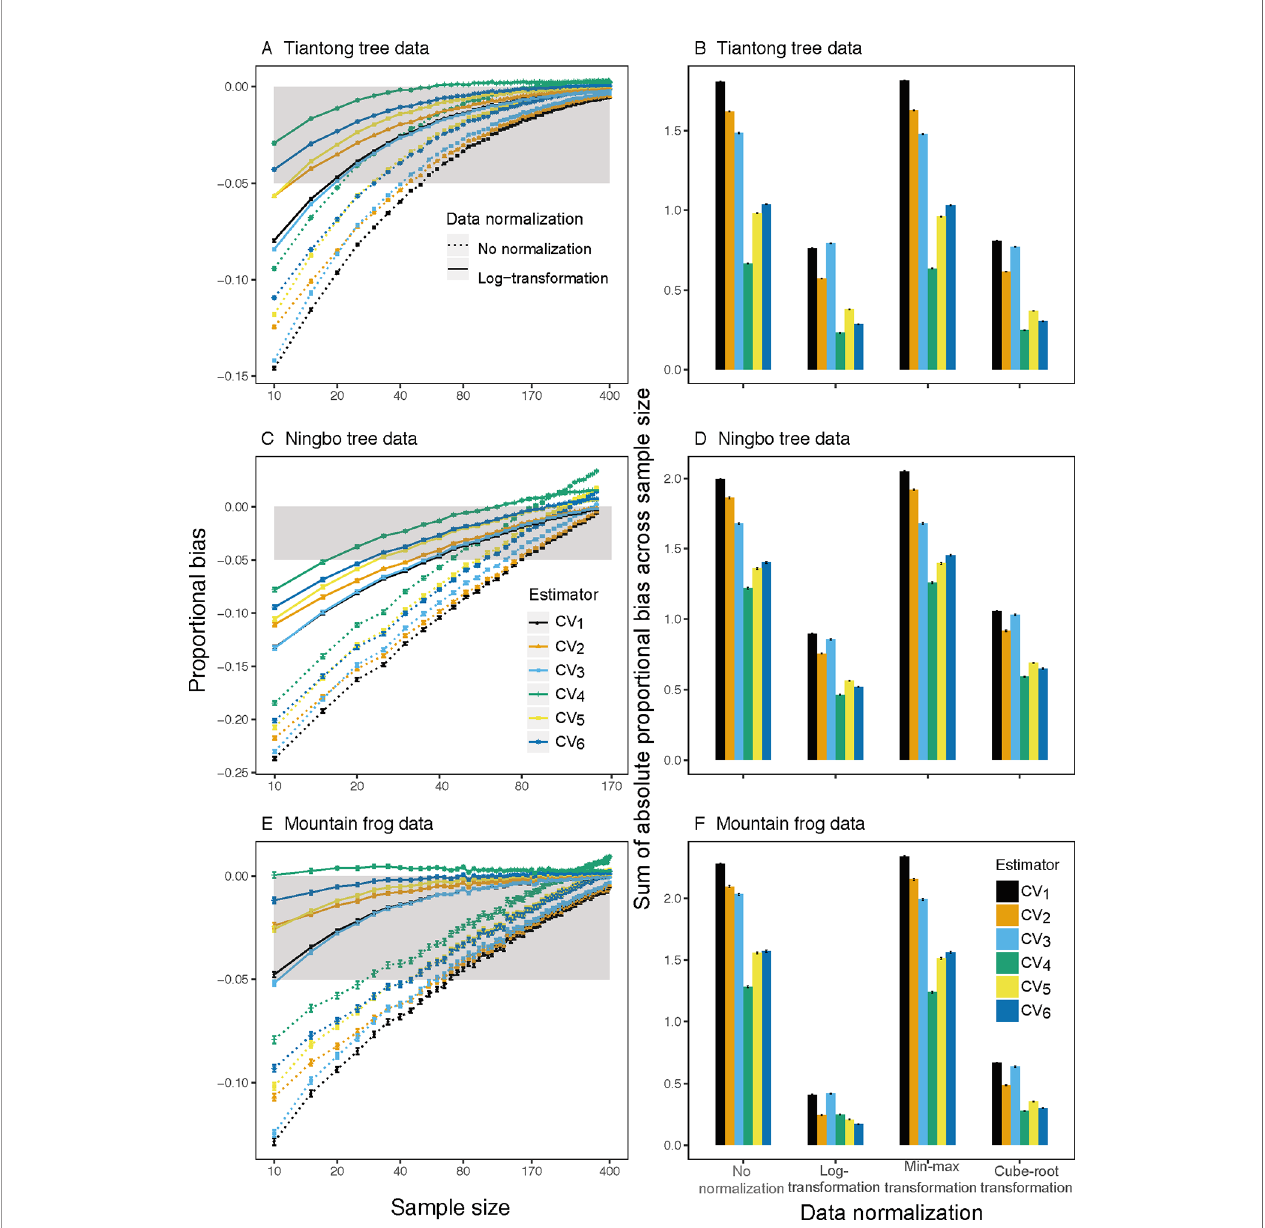
FIGURE 2 | Mean proportion of bias (left panels) on sample size from 10 to 400 for all traits and species based on observed raw (dotted lines) and log-transform (solid lines) trait values and sum of absolute mean proportion of bias across all sample size (right panels) for the i th ( i ∈ { 1,2,3,4,5,6, }) CV estimator based on observed raw, log-transform, min-max transform, and cube-root transform trait values in three individual-based trait datasets. Gray area is the region in which the absolute mean proportion of bias is less than